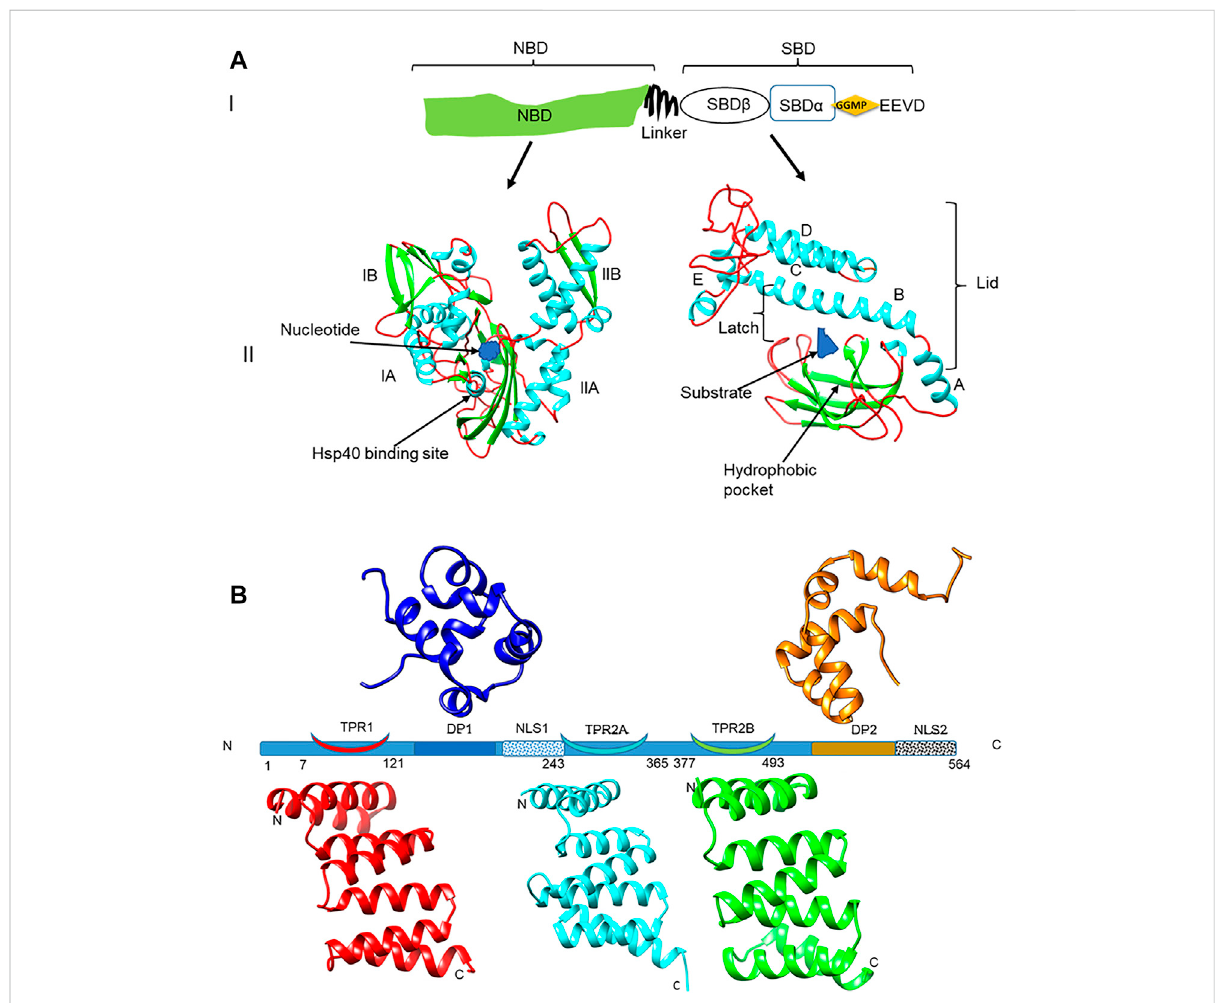
FIGURE 1 Domain representation of PfHsp70-1 and PfHop (A) (panel I): representation of the linear structural organization of PfHsp70-1 showing the NBD, a highly charged linker, and the-SBD. The C-terminal EEVD motif is illustrated. Panel II: Three-dimensional model of PfHsp70-1 domains. The N-terminal NBD which is subdivided into lobes IA, IB, IIA, and IIB, respectively, is shown. Also illustrated are the bound nucleotide (blue) and the Hsp40 co-chaperone binding site, respectively. The C-terminal SBD of the protein is shown on the right hand side. The hydrophobic